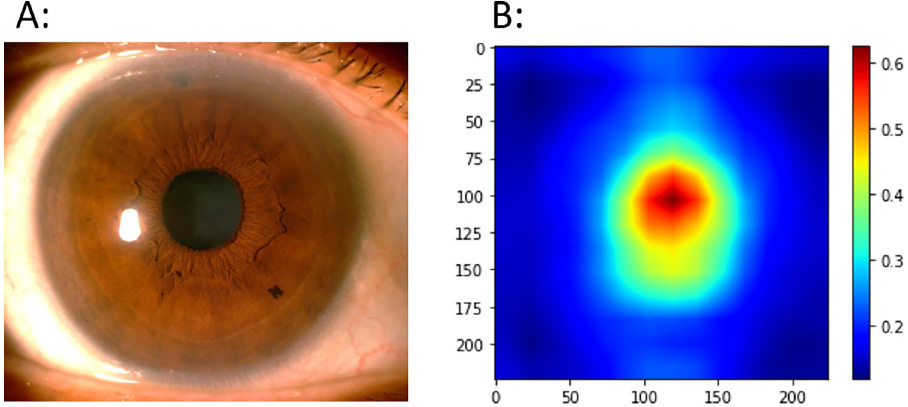
Fig 3. Saliency map illustrating the structural features used by the deep learning algorithm to predict anterior chamber depth in algorithm validation.